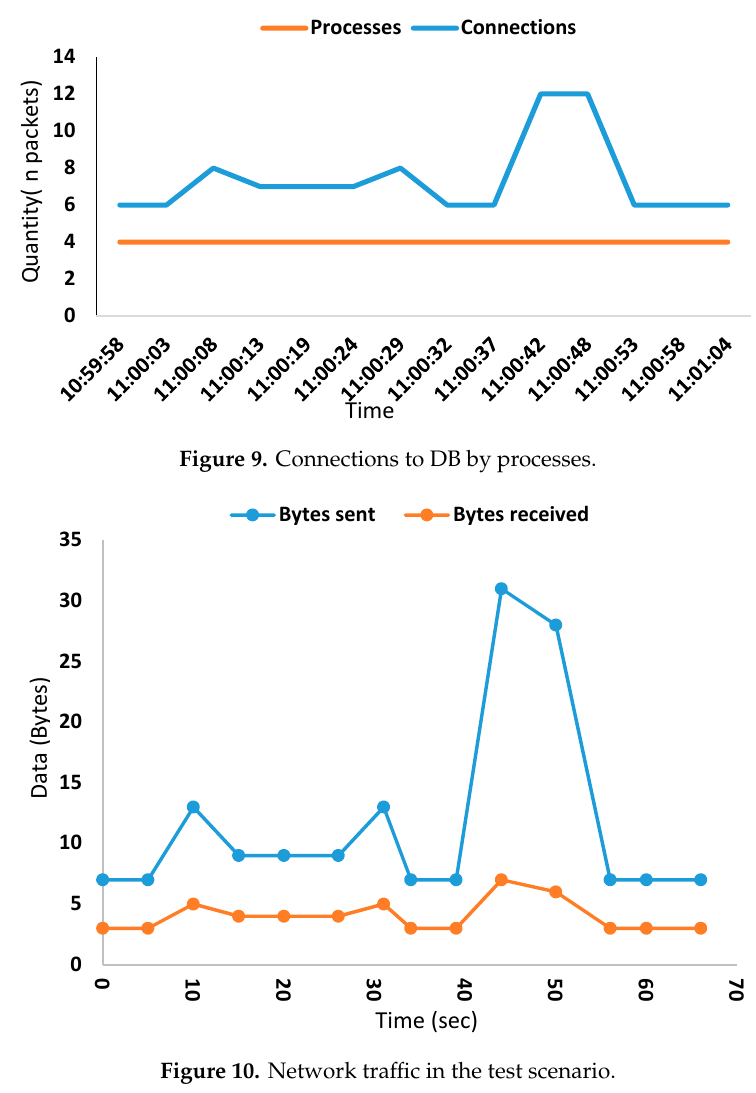
Agronomy 2019 , 9 , x FOR PEER REVIEW Figure 10. Network tra ffi c in the test scenario. Figure 10. Network traffic in the test scenario.